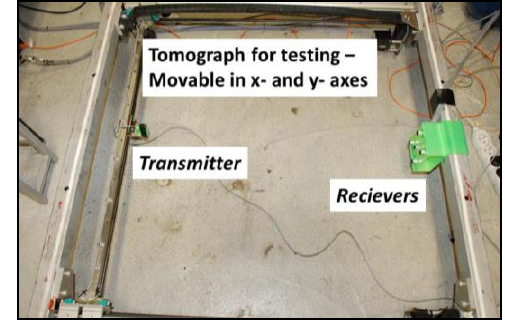
Fig. 13. The tomograph for principle testing (with no flow).